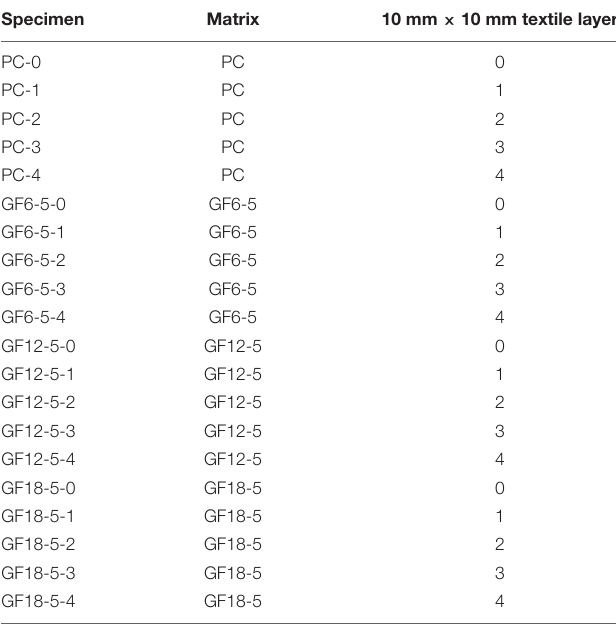
TABLE 3 | Basalt textile reinforced concrete sheets.